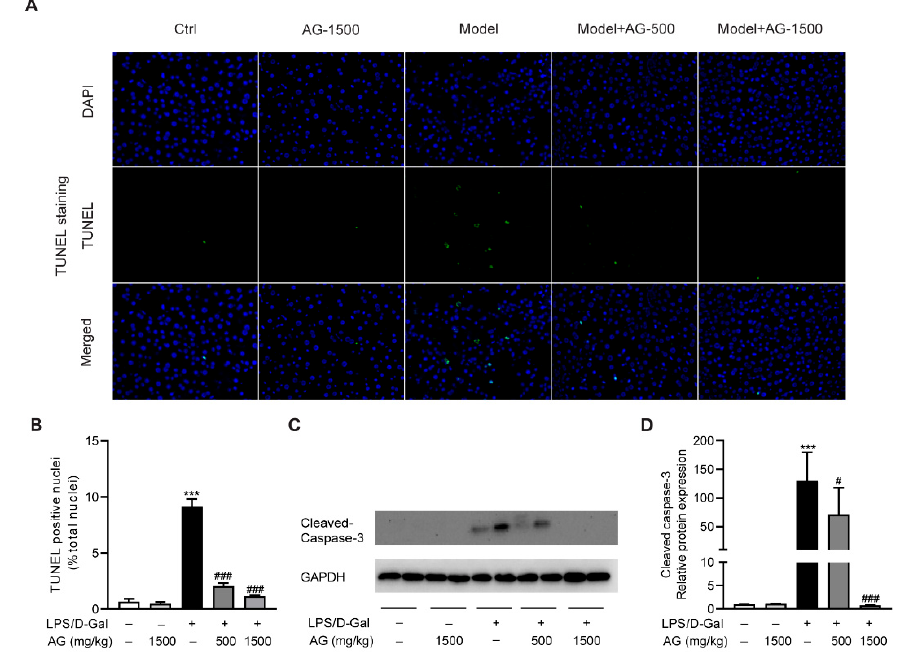
Figure 2. Ala-Gln suppressed apoptosis in LPS/D-Gal-treated mice. ( A ) TUNEL staining (original Figure 2. Ala ‐ Gln suppressed apoptosis in LPS/D ‐ Gal ‐ treated mice. ( A ) TUNEL staining (original magnification, × 400) of liver tissues. ( B ) Quantitation of TUNEL-positive cells in liver. ( C , D ) Protein magnification, ×400) of liver tissues. ( B ) Quantitation of TUNEL ‐ positive cells in liver. ( C , D ) Protein expression levels of cleaved-caspase-3 in liver. Data are expressed as mean ± SD, n = 6–8 in each expression levels of cleaved ‐ caspase ‐ 3 in liver. Data are expressed as mean ± SD, n = 6–8 in each group. *** p < 0.001 vs. vehicle-treated control group, # p < 0.05, ### p < 0.001 vs. LPS/D-Gal-treated group. *** p < 0.001 vs. vehicle ‐ treated control group, # p < 0.05, ### p < 0.001 vs. LPS/D ‐ Gal ‐ treated model model group.